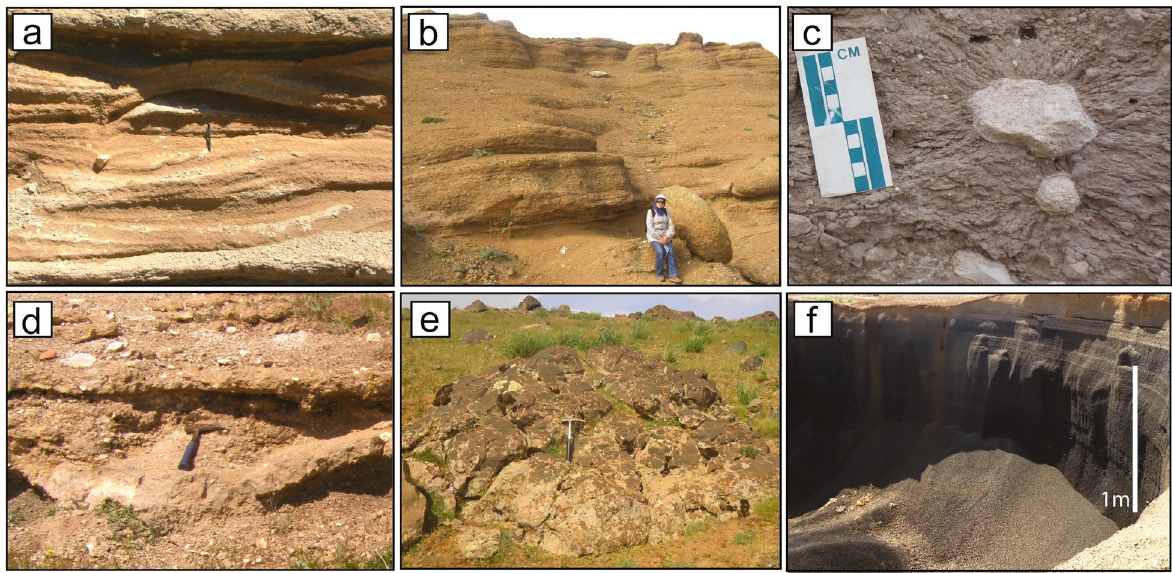
Fig. 7. Phreatomagmatic eruptive